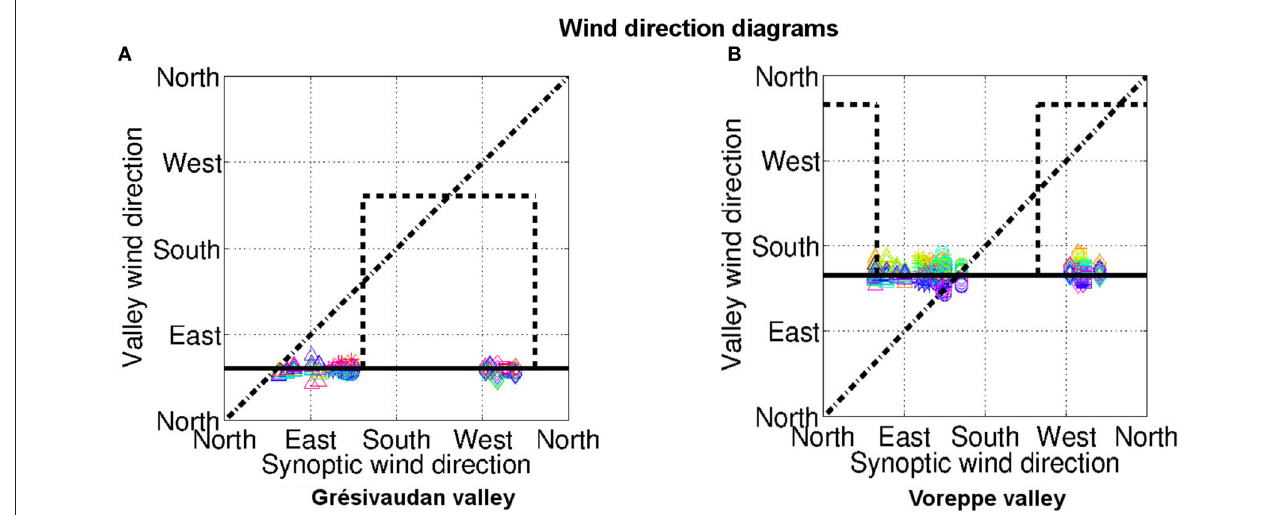
FIGURE 6 | Direction of the valley-wind vs. that of the synoptic wind. The valley-wind direction is plotted every hour of the C1 configuration, each hour having a different color, and each episode is represented by a symbol: ◦ : I 1 , ⋆ : I 5 , 2 : I 6 , ⋄ : I 7 , △ : I 8 . The horizontal black line is the direction of the valley close to the Grenoble basin. (A) Grésivaudan valley; (B) Voreppe valley. The valley-wind direction is averaged over the horizontal grid points displayed in Figure 7A , from the ground up to 400 m for the Grésivaudant valley and up to 600 m for the Voreppe valley. See text for